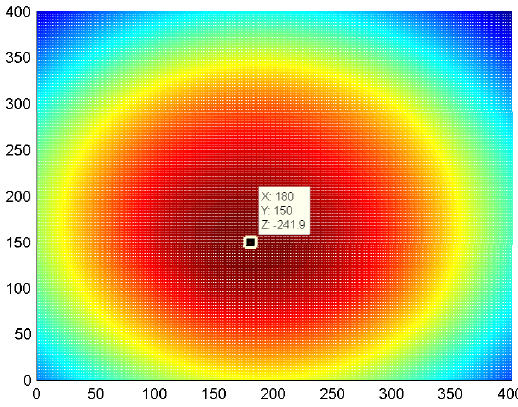
Figure 11. Thresholding fusion tomography map of denoising signal, based on probabilistic reconstruction algorithm; evaluated damage location: (180,150) (unit: mm).